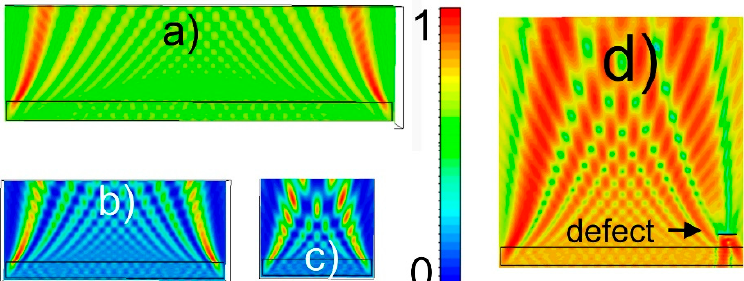
Figure 1. Full-wave simulation results of the diffraction on a rectangular phase plate, with widths of ( a ) 36 λ , ( b ) 24 λ , ( c ) 12 λ , and ( d ) a rectangular phase plate with defect.